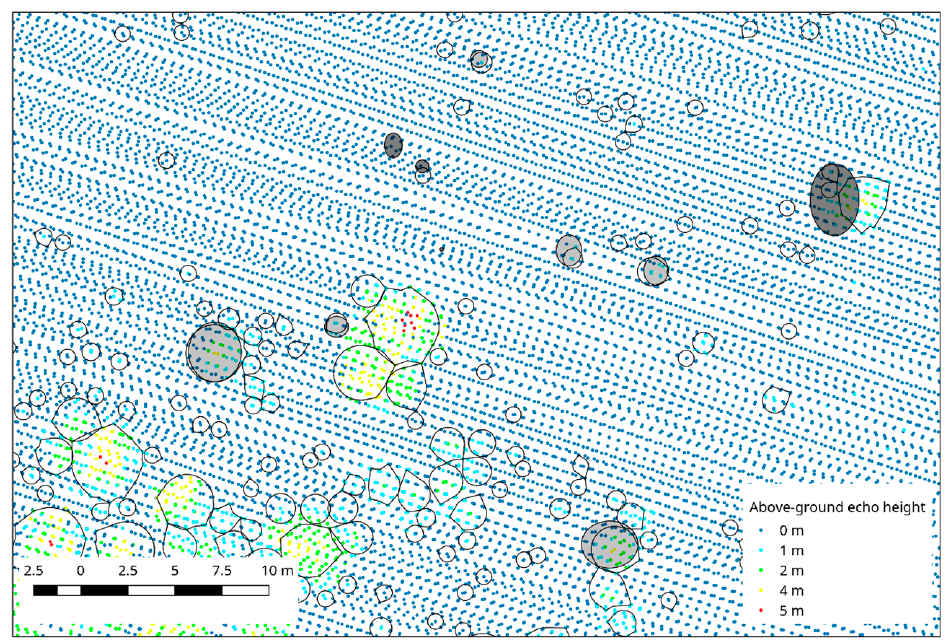
Figure 6. Single-tree segments from the described procedure (hollow segments) and field-measured crown ellipses of detected (light grey) and undetected (dark grey) trees. Note that only a sample of the trees was measured in the field. ALS echoes are colored according to the above-ground height. Table 5. Detection rates with field-measured segments as